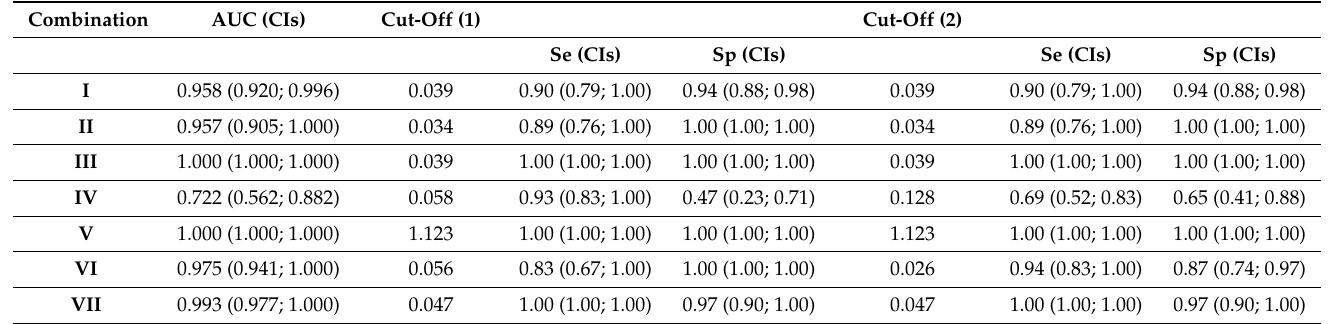
Table 1. Estimated AUCs, Se, Sp and associated 95% Confidence Intervals (CIs) at selected cut-offs that maximize the Youden’s J statistic (1) or correspond to the point closest to upper left corner of the AUC plot (2). Results are for the following combinations: group A and B for the rLPS antigen in domestic pigs (I); group A and C for the rLPS antigen in domestic pigs (II); group A and B for the B. suis 1330 smooth antigen in domestic pigs (III); group A and C for the B. suis 1330 smooth antigen in domestic pigs (IV); group A and C for the ratio of smooth B. suis 1330/the smooth Y. enterocolitica O:9 in domestic pigs (V); group A and B for the rLPS antigen in wild boars (VI); group A and B for the B. suis 1330 smooth antigen in wild boars